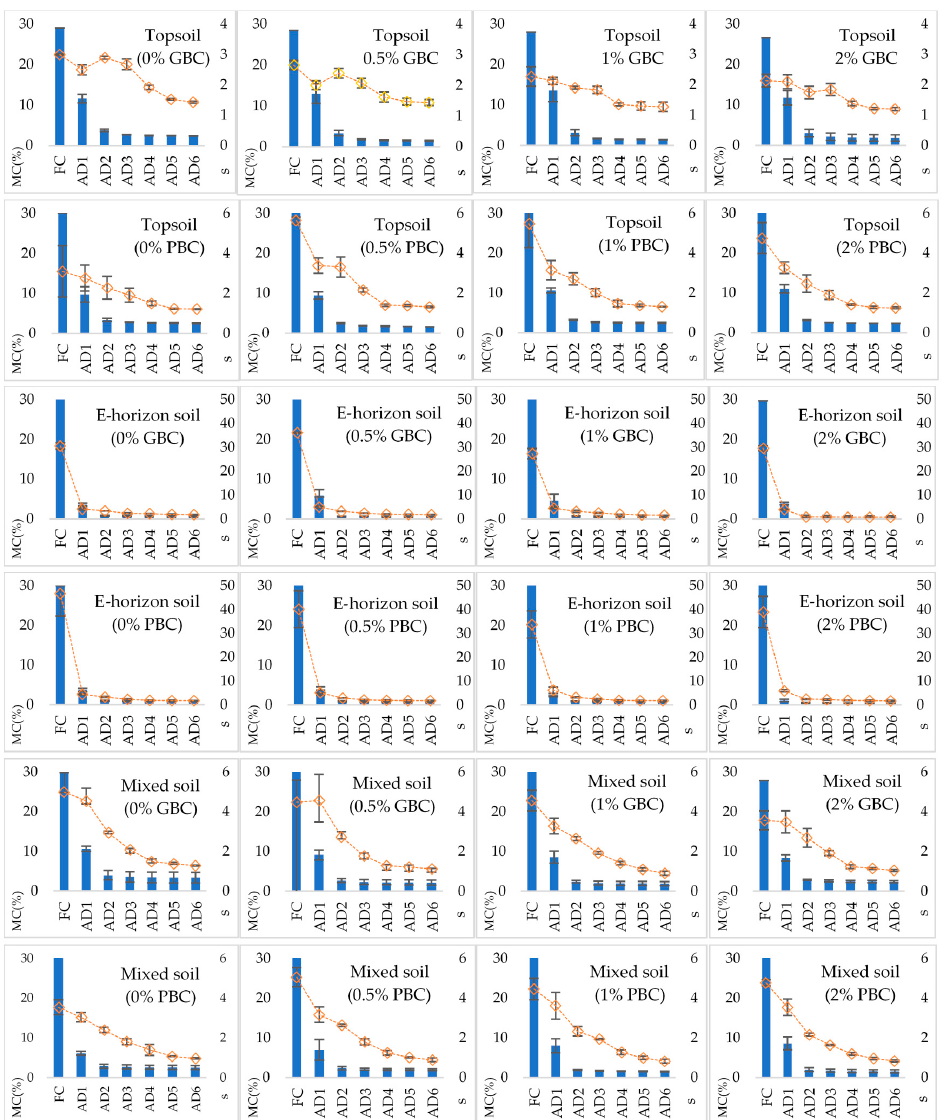
Figure 9. Temporal effect on moisture content (MC) vs. water repellency (WR) in biochar-amended soil. Samples were placed 28 °C in the oven after field capacity level from day 1 to day 6. Abbreviations: GBC—granular biochar; PBC—powder biochar.